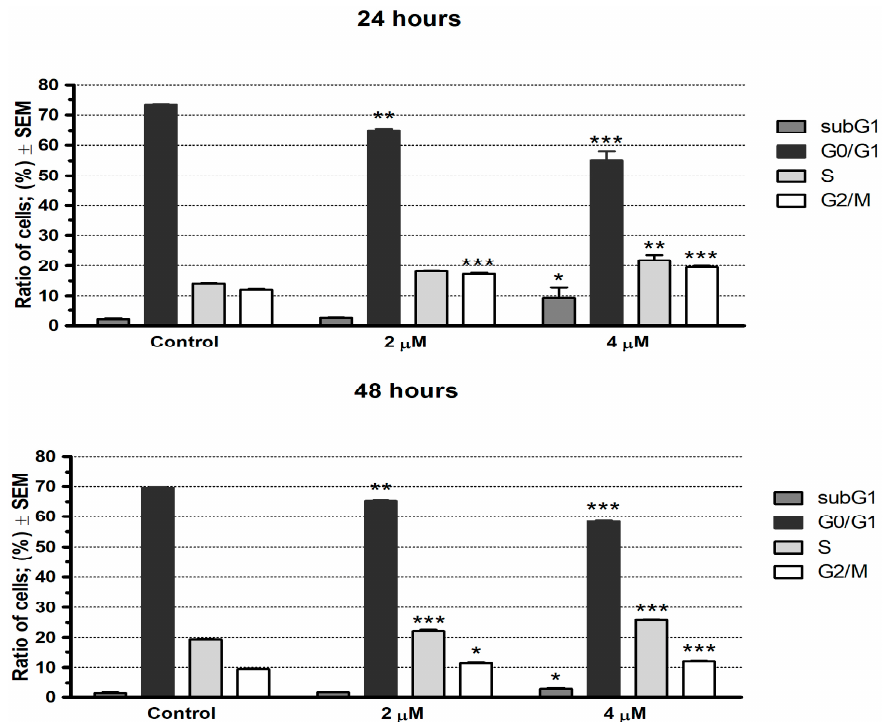
Figure 2. Cell cycle analysis by flow cytometry. 13AES3 induced cell cycle disturbances, characterized by an increased rate of the S and G2/M cell populations at the expense of a reduced rate of G0/G1 cells in SiHa cell lines. The upper and lower panels show the effects of 13AES3 on cell cycle phases at 24 and 48 h post-treatment, respectively. *, **, and *** indicate significance at p < 0.05, p < 0.01 and p < 0.001, respectively.